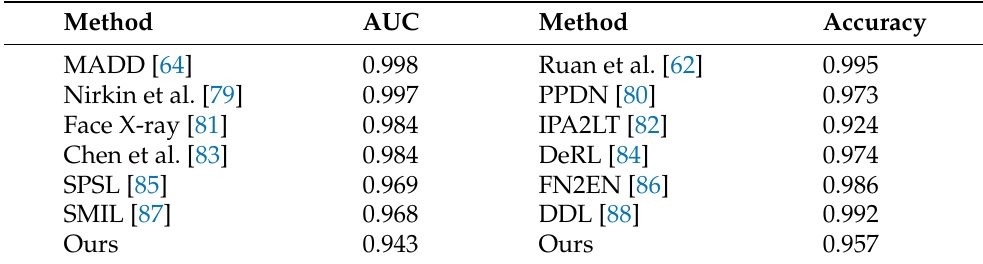
Table 4. Comparing AUC results (left) on FF++ [77] dataset and accuracy results (right) on CK+ [78] dataset against existing methods. Our approach shows its effectiveness in both deepfake detection and facial expression recognition.